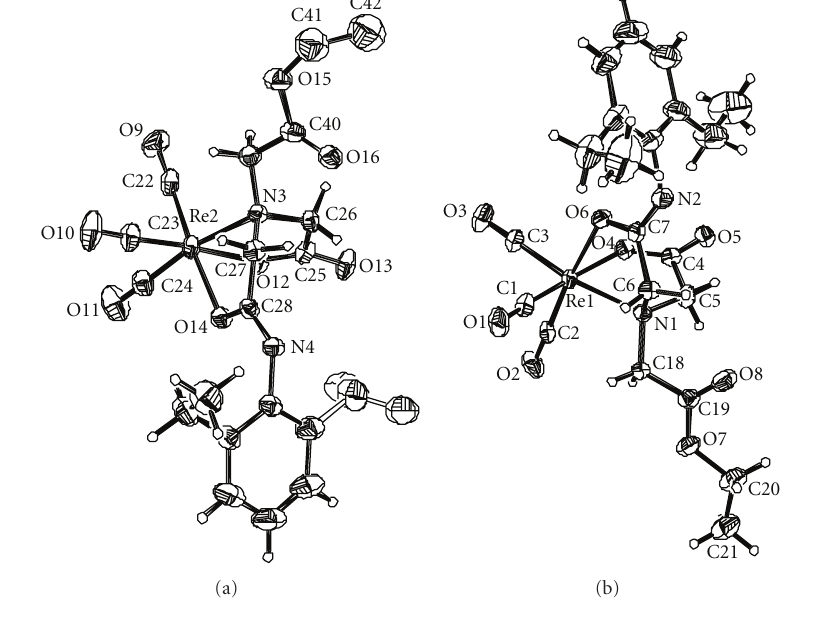
Figure 3: Ultraviolet Spectrum of the EHIDA (a) and Re(CO) 3 (L) (b).